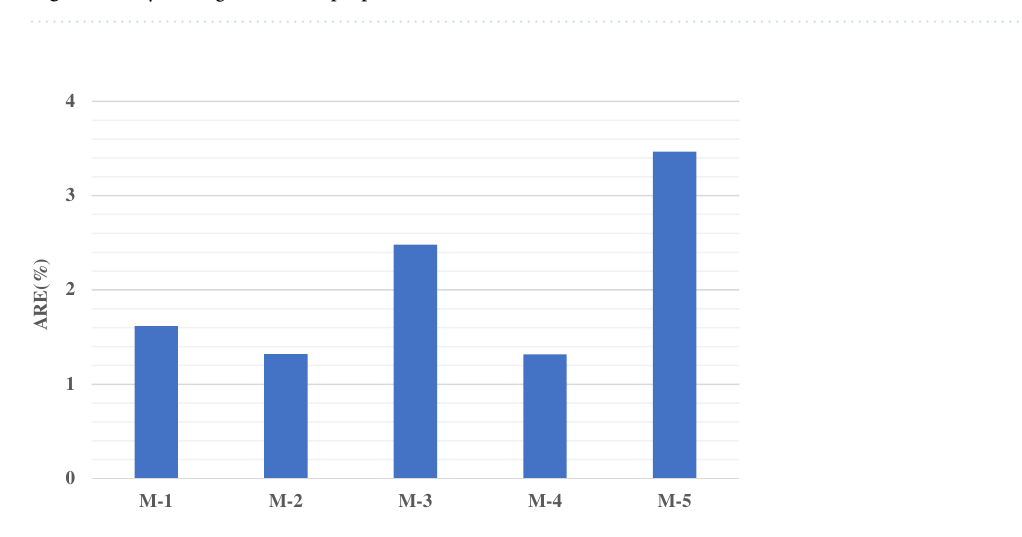
Figure 5. Average Relative Error of each proposed